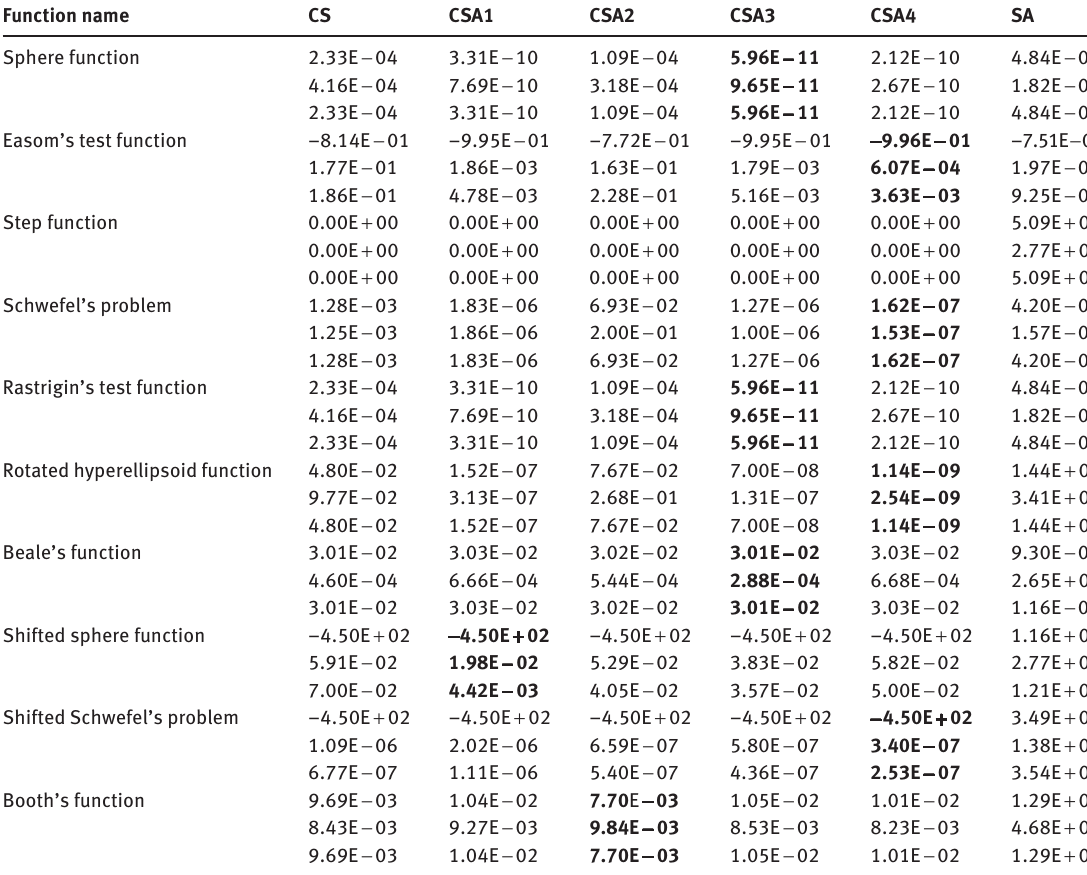
Table 1: Experimental Results of the Algorithms for each of the 10 Benchmark Functions. Function